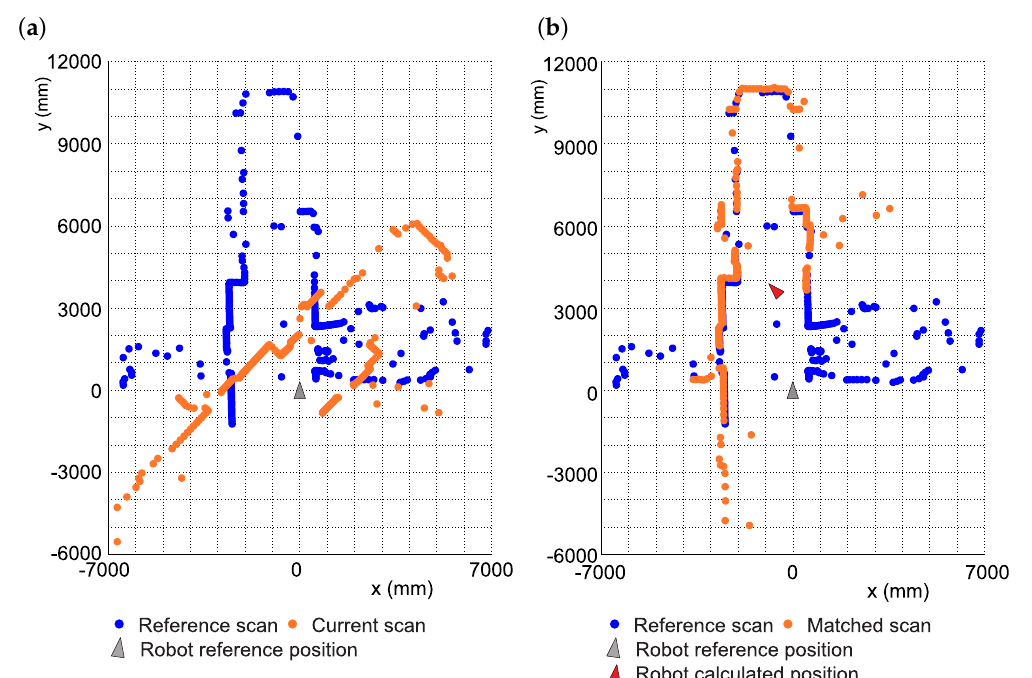
Figure 2. Scan matching: problem definition. ( a ) Scans before alignment ( b ) Scans after